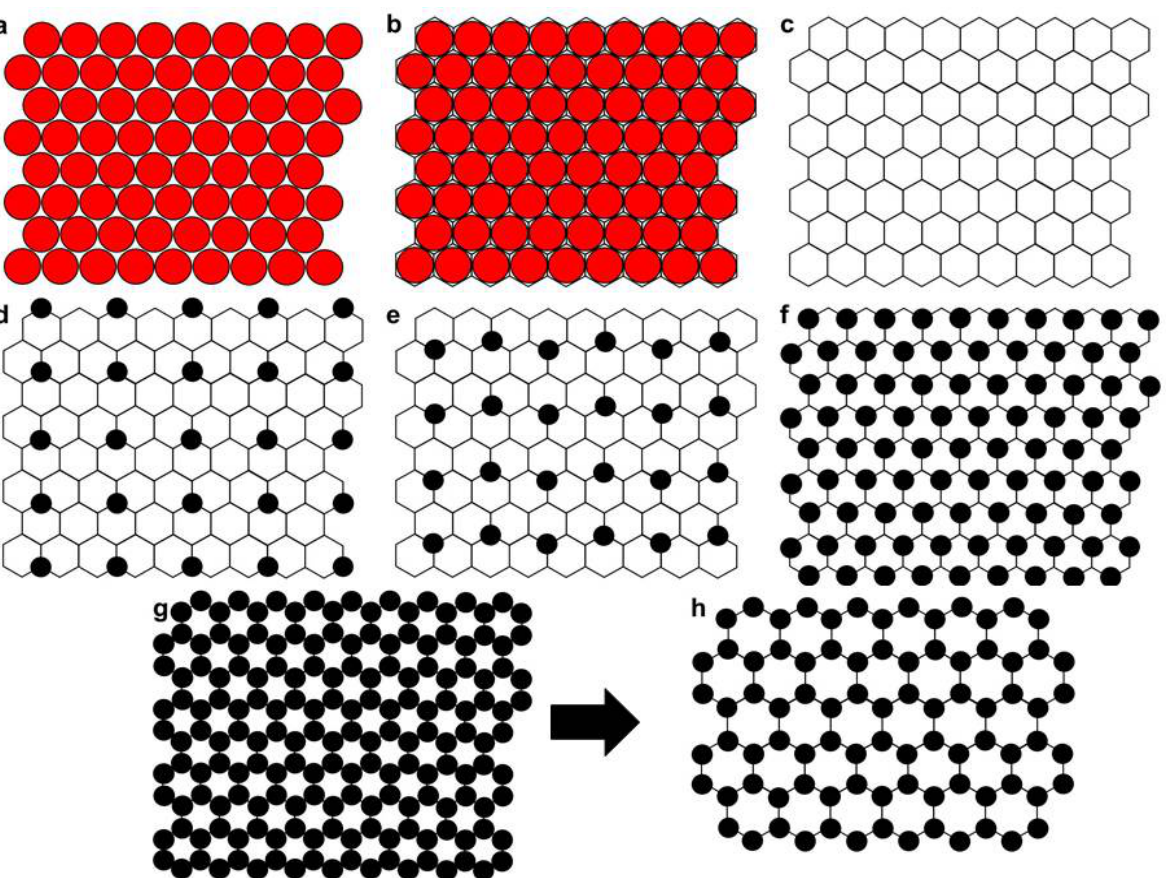
Figure 2. A model in which the cholesterol inserts without causing a change in the spacing between the PC molecules. The total area occupied by all the molecules does not change with increasing χ . In ( a ), each circle represents one PC molecule; a hexagonal lattice may C be drawn around the PC molecules, ( b ) the hexagonal lattice, ( c ) is then used for placement of the cholesterol molecules, shown in ( d ), ( e ) and ( f ) as black circles. Regular arrays are shown for χ = 0.2 (d), 0.25 (e) and 0.5 (f). The model is expected to be reasonable up to C χ = 0.5, as described in the text. A regular array is also shown ( g ) at the solubility limit of C χ = 0.67 [6]; at this high a cholesterol content, the spacing between the PC molecules C would be expected to increase, as indicated in Figure 1 and in ( h ). The relative sizes of the PC and the cholesterol do not affect the placement of the cholesterol in this model; cholesterol is drawn smaller here but without precise reference to scale. Both the PC and the cholesterol are represented here by circles. This will be a reasonable description for the PC, which is approximately cylindrical, but will not be an accurate description of the cholesterol. The cholesterol may be considered as an irregular shape that is placed between the PC molecules at positions indicated by the black filled